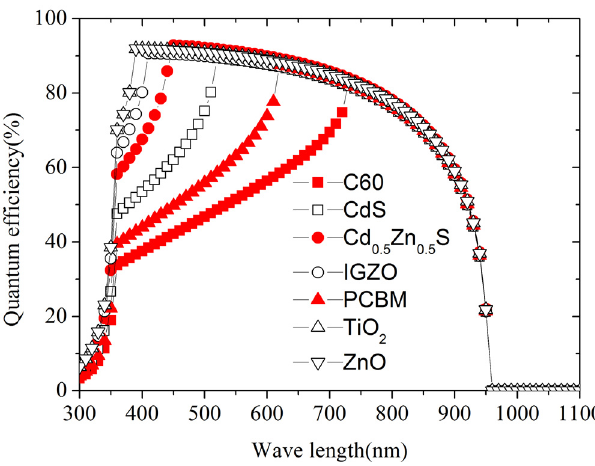
Figure 3. E ff ect of di ff erent ETL materials on Figure 3. Effect of different ETL materials on QE.